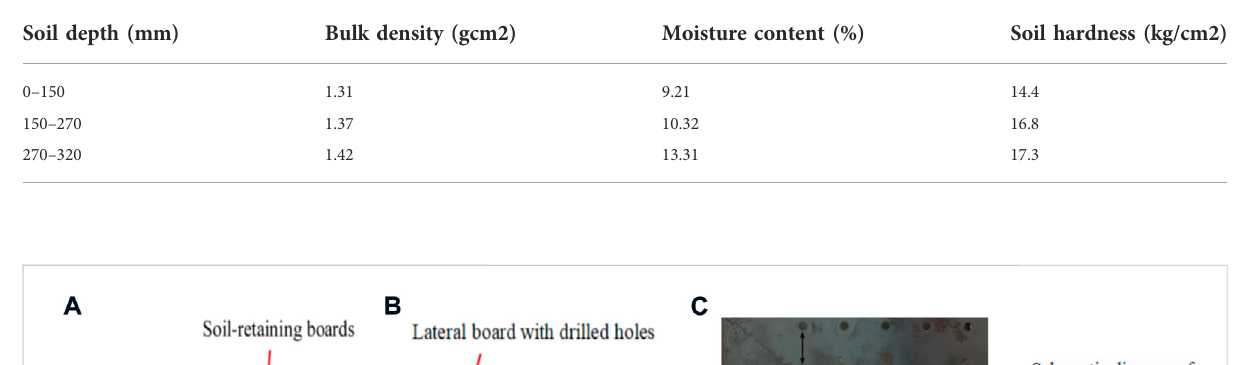
TABLE 2 Basic physical parameters of the soil.